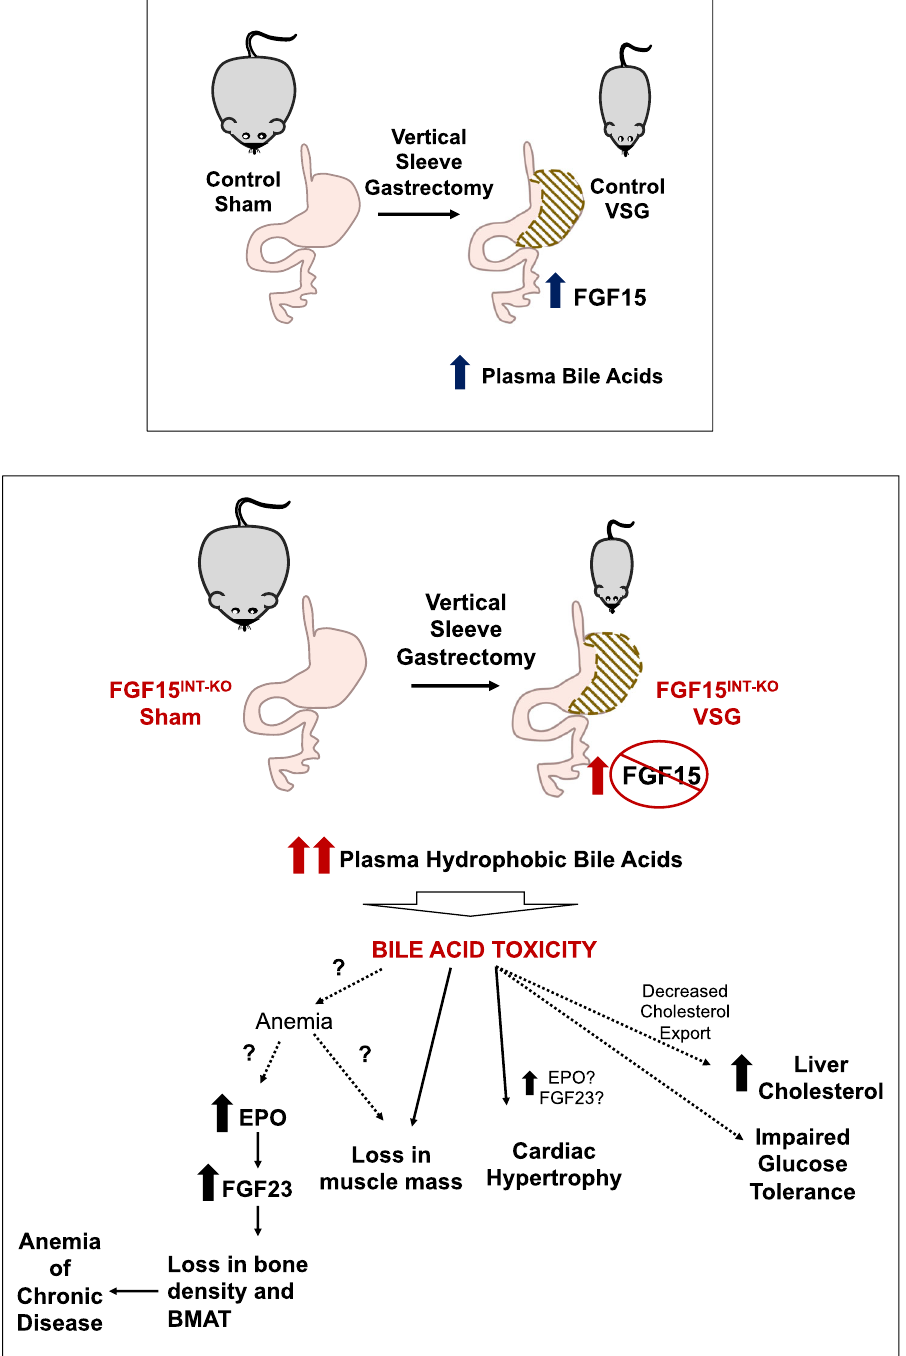
Fig. 8 Intestinal-derived FGF15 protects against deleterious effects following sleeve gastrectomy in mice. VSG leads to an increase in ileal expression of FGF15 and total plasma bile acids. In the absence of intestinally derived FGF15 (FGF15 INT-KO ), VSG leads to an even greater increase in circulating total and speci fi cally, hydrophobic bile acids. We speculate that the increase in hydrophobic bile acids leads to bone marrow dysfunction, which increases EPO and FGF23 levels that likely contribute to potentially serious loss of bone mass, bone marrow adipose tissue (BMAT), inducing anemia of chronic disease. FGF15 INT-KO VSG mice have a loss of muscle mass and cardiac hypertrophy, as a result of bile acid toxicity or secondary to anemia of chronic disease. FGF15 INT-KO VSG mice also have increased hepatic cholesterol and they do not show improved glucose tolerance following FGF15 INT-KO VSG mice. It remains unclear if and how bile acid hypertrophy and blocks muscle atrophy induced by glucocorti- coid treatment, sarcopenia and obesity 49 . The mechanism behind toxicity induces anemia of chronic disease leading to the these fi ndings is not well understood, but bile acids may play a increase in EPO and FGF23. Further supporting the bile acid role. We also hypothesize that dramatic increases in EPO and toxicity hypothesis, FGF15 INT-KO VSG mice have cardiac FGF23 play a major role in bone density and BMAT loss in hypertrophy (Fig. 3). Elevated plasma bile acids that occur in